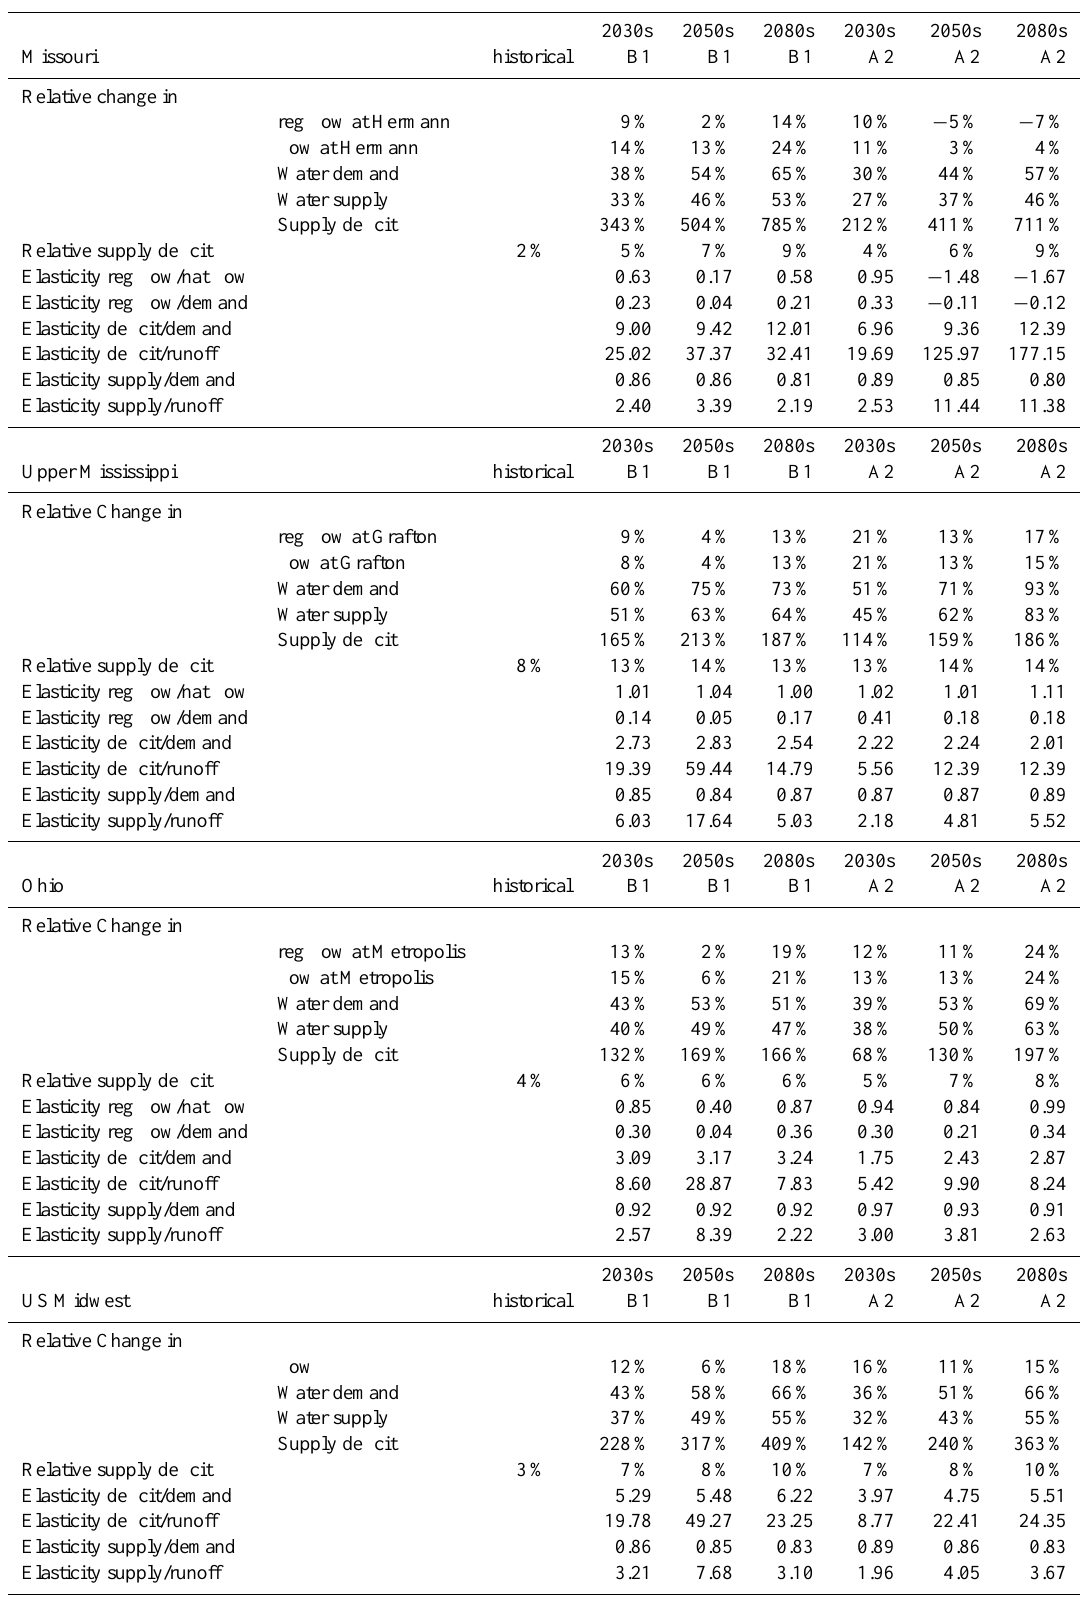
Table 3. Relative change in annual discharge, water demand, water supply and supply deficit with respect to the historical period. Elasticities of water supply and supply deficit to changes in demand or discharge with respect to the historical